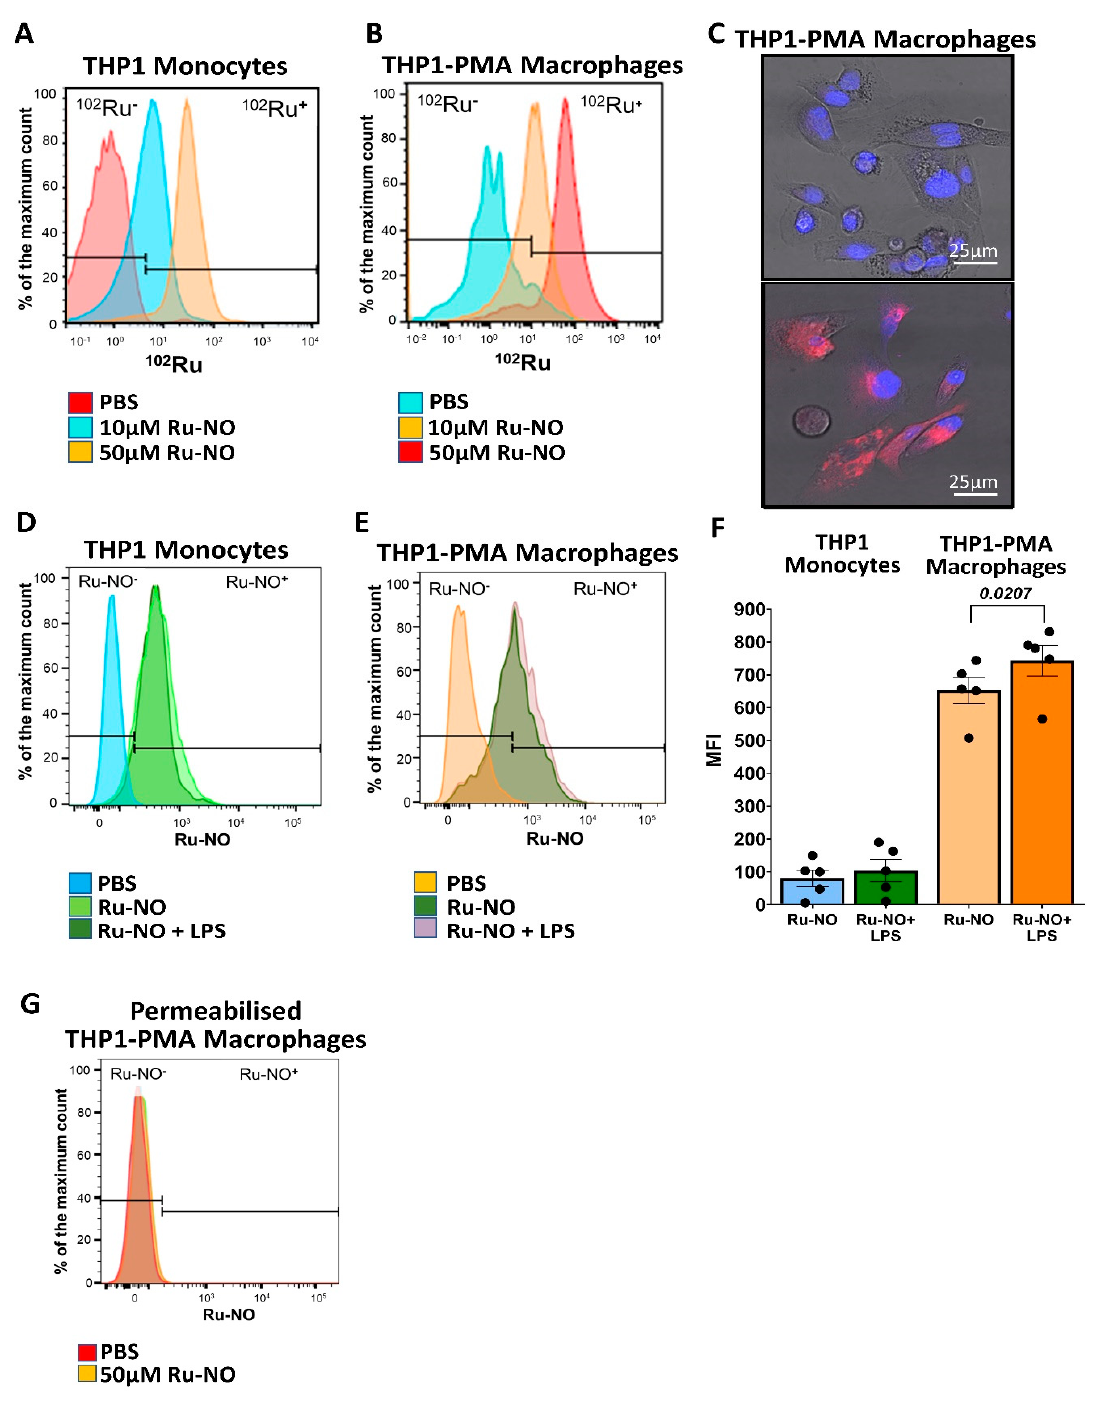
Figure 1. Ru-NO sensor uptake and detection in human THP1 monocytes and THP1-PMA macrophages. THP1 monocytes and macrophages were exposed to the Ru-NO sensor to assess sensor uptake and fluorescence detection. The histograms of 102 Ru in ( A ) THP1 monocytes and ( B ) macrophages exposed to 10 and 50 µM of Ru-NO as assessed by Mass Cytometry (CyTOF). ( C ) Confocal microscopic images of THP1-PMA macrophages treated with PBS (top) and 50 µ M Ru-NO (bottom) (red: Ru-NO, and blue: DAPI). Representative flow cytometry histograms of Ru-NO fluorescence in ( D ) THP1 monocytes and ( E ) THP1-PMA macrophages with/without LPS stimulation ( F ) with analyses. ( G ) Lack of Ru-NO fluorescence detection in permeabilised THP1- PMA macrophages by flow cytometry. Mean ± SEM of the mean fluorescence intensity (MFI) of independent experiments, and p values derived from a paired t -test (n = 5